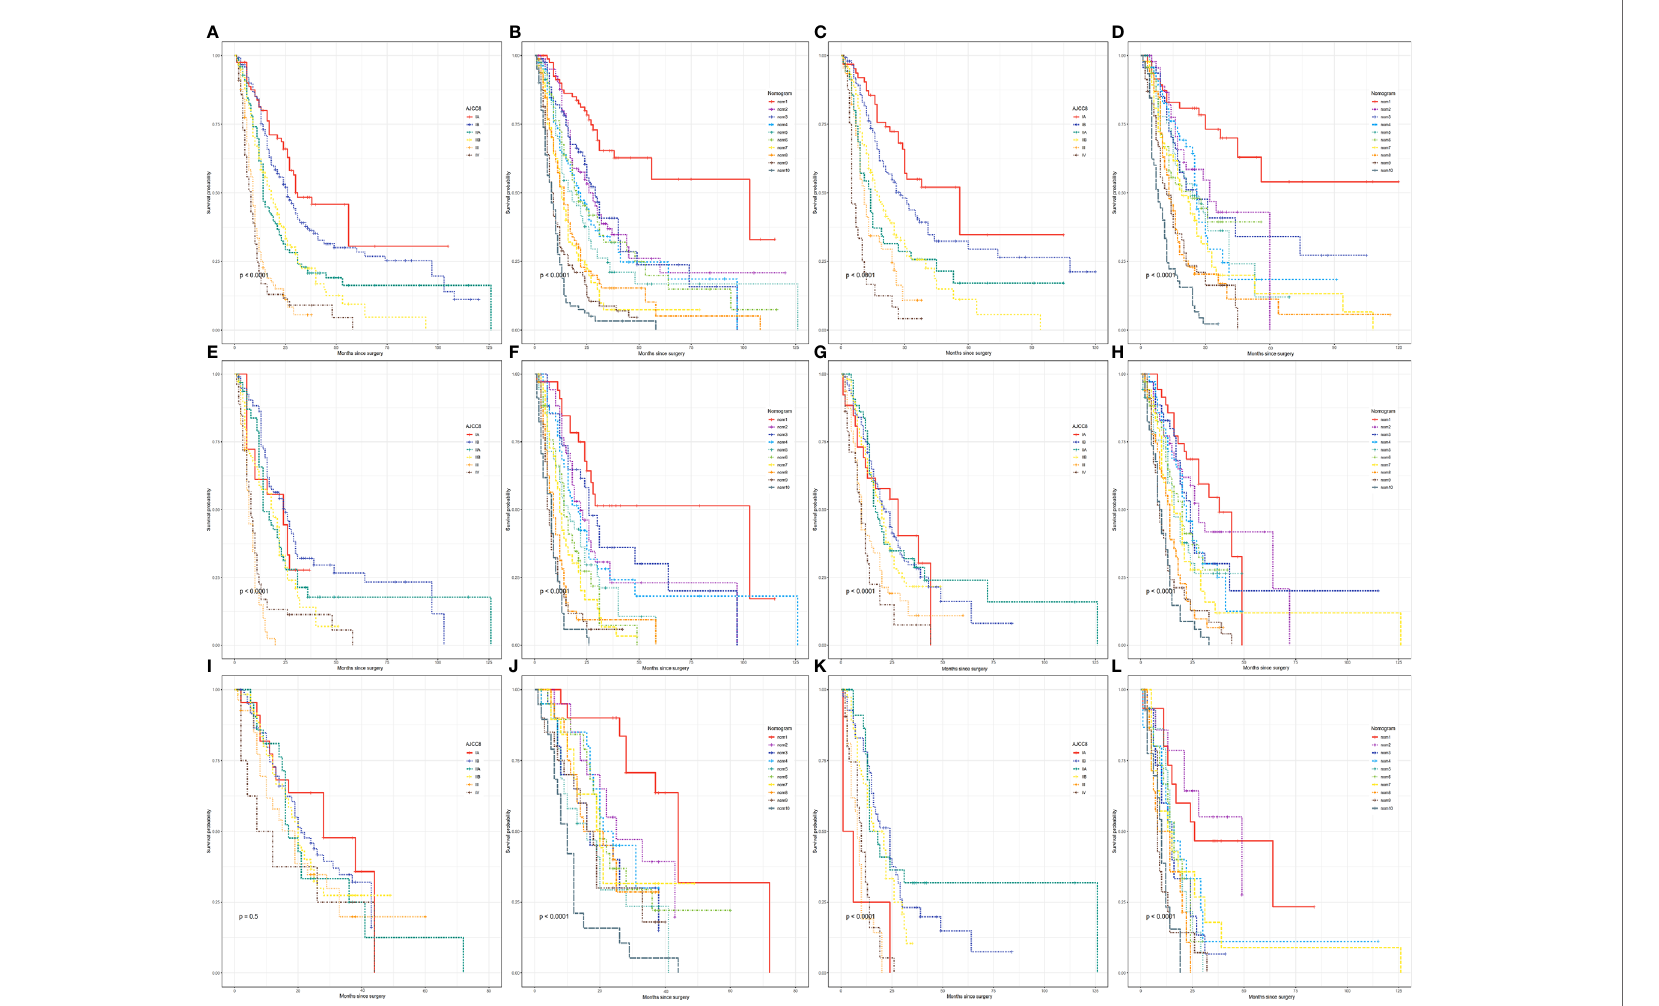
FIGURE 5 | Kaplan – Meier curve analysis of risk classi fi cation. Risk classi fi cation of the (A, B) PDAC group, (C, D) PHC group, and (E, F) PBTC group in the training cohort. Risk classi fi cation of the (G, H) PDAC group, (I, J) PHC group, and (K, L) PBTC group in the test cohort. All log-rank p values for trends were <0.0001, except p=0.5 for (I)